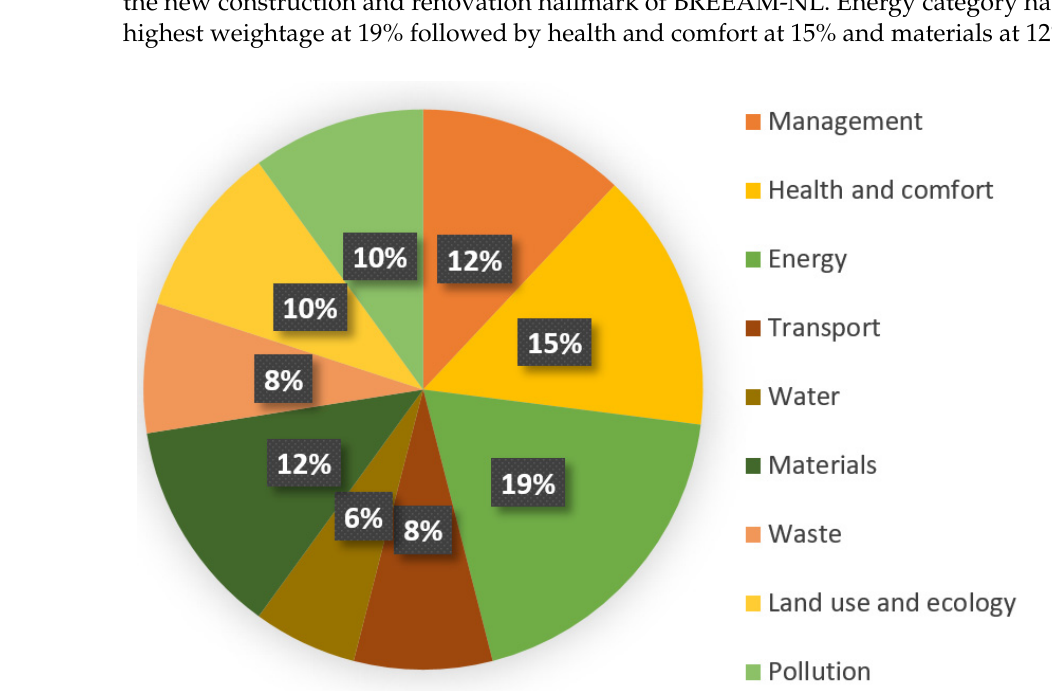
Figure 1. BREEAM-NL new construction and renovation—composition. The energy category of BREEAM-NL is divided into credits aiming at measures to improve the energy performance of the building through design features and efficient installations. These credits are worth a maximum of 29 points, plus an additional 2 points available for exemplary performance. The description of the credit requirements and associated points are provided in Table 2. This table serves as the input for the semi- structured interviews conducted to investigate the potential of using BIM for automated assessments in Section 4, the associated impacts of BIM use on different actors in Section 5, and recommended digitalization starting points in Section